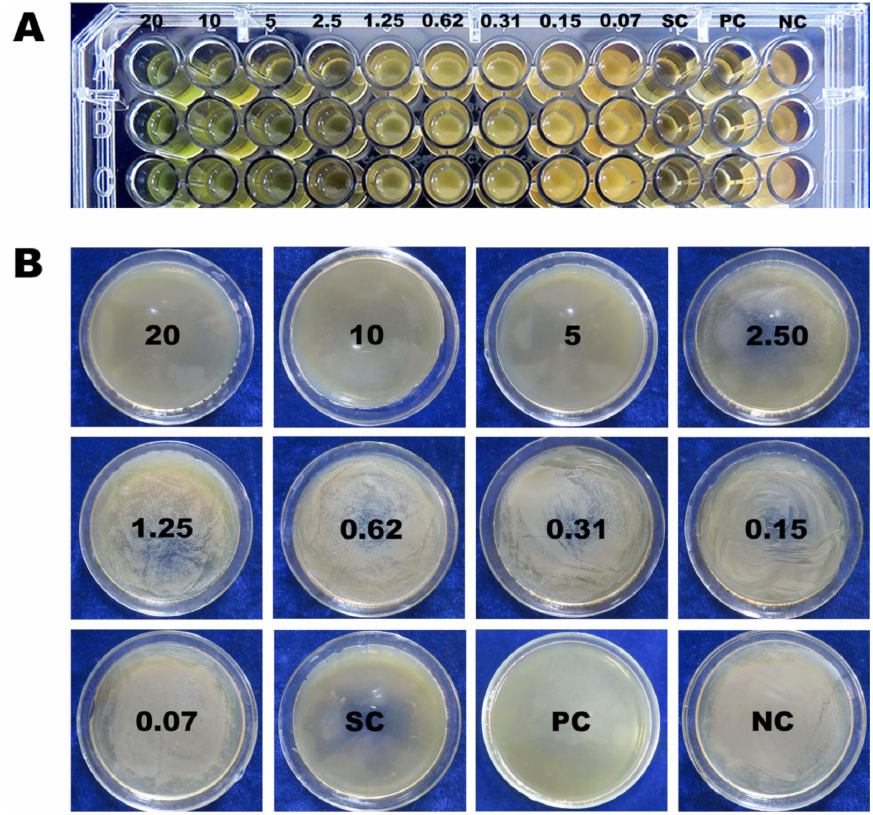
Fig. 2: Photographs of the minimal inhibitory concentration (MIC) (A) and minimal bactericidal concentration (MBC) (B) tests against Clavibacter michi- ganensis subsp. michiganensis (Cmm). In the photographs of MIC and MBC tests, concentrations of Laminaria japonica extracts (mg/mL) were marked as the black numbers. SC: sterility control (only culture medium); PC: positive control (culture medium, Cmm, and 10 mg/mL streptomycin); NP: negative control (culture medium and Cmm).